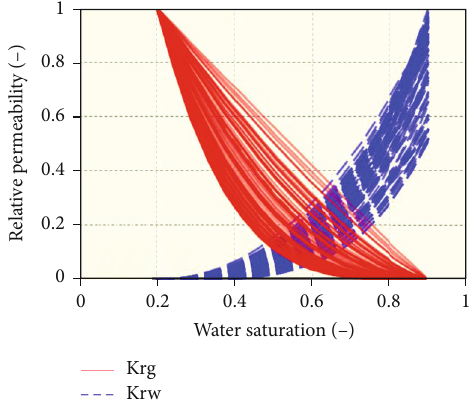
Figure 7: Relative permeability curves versus water saturation of 84 history matching solutions.